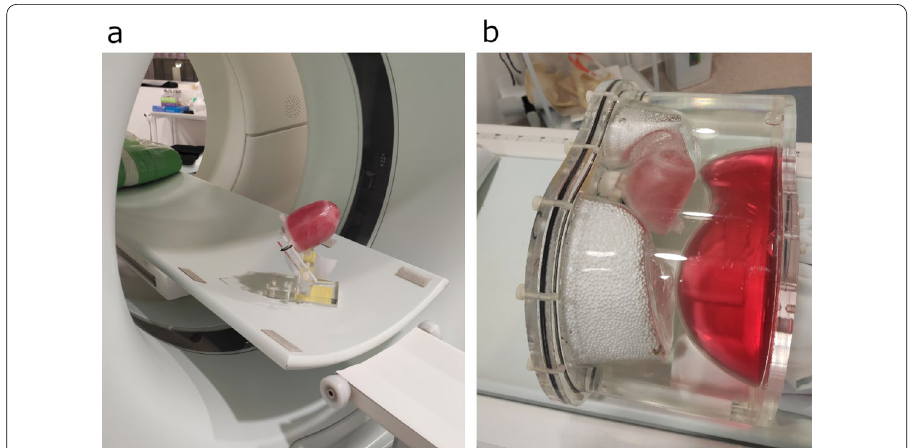
Fig. 5 "In air” measurement positioning of LVm phantom on the SPECT/CT scanner bed ( a ), and the “in torso” setup with the Anthropomorphic Torso Phantom, when the LVm phantom is placed at the location of the original heart insert ( b